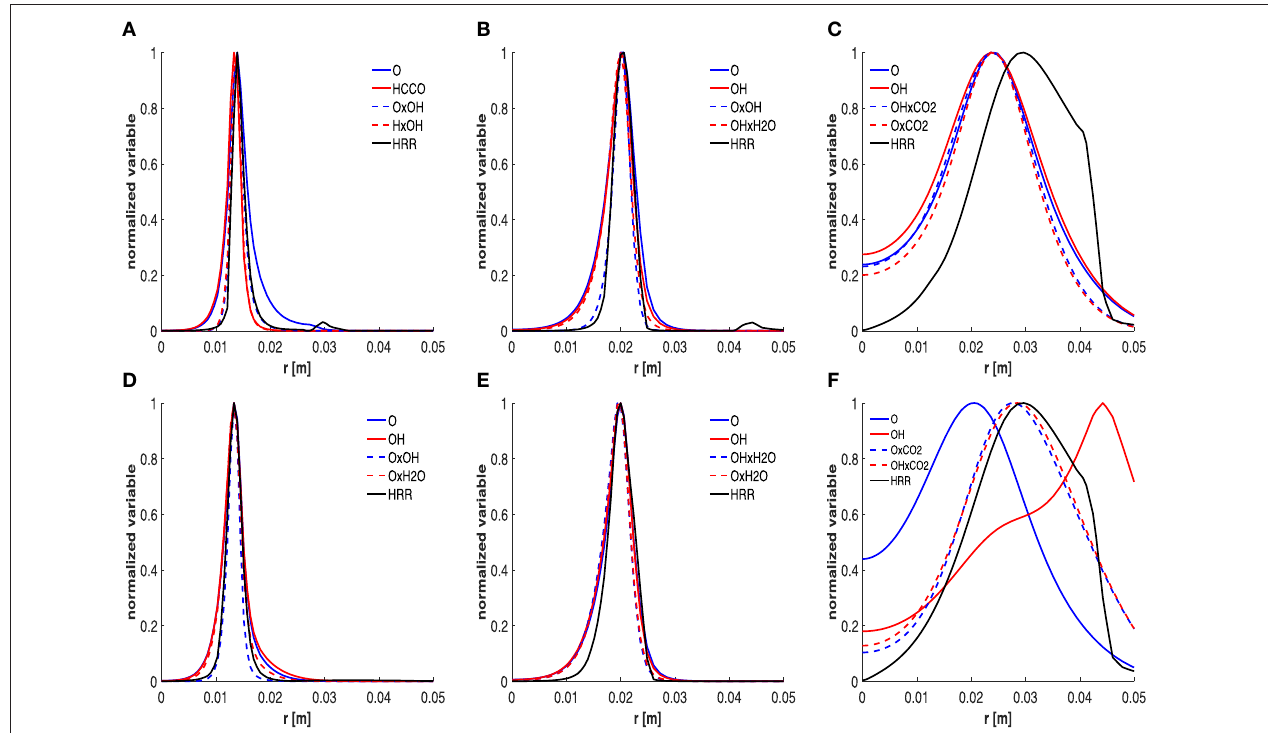
FIGURE 9 | Trends of normalized HRR, top-two mole fractions and combinations at 60 (A,D) , 120 (B,E) and 550 (C,F) mm, respectively. First and second row refer to the HM1 and HM3 cases, respectively.